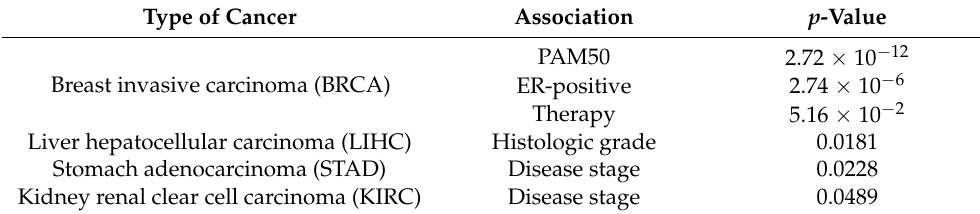
Table 2. TCGA analysis of the uc.147 region. Type of